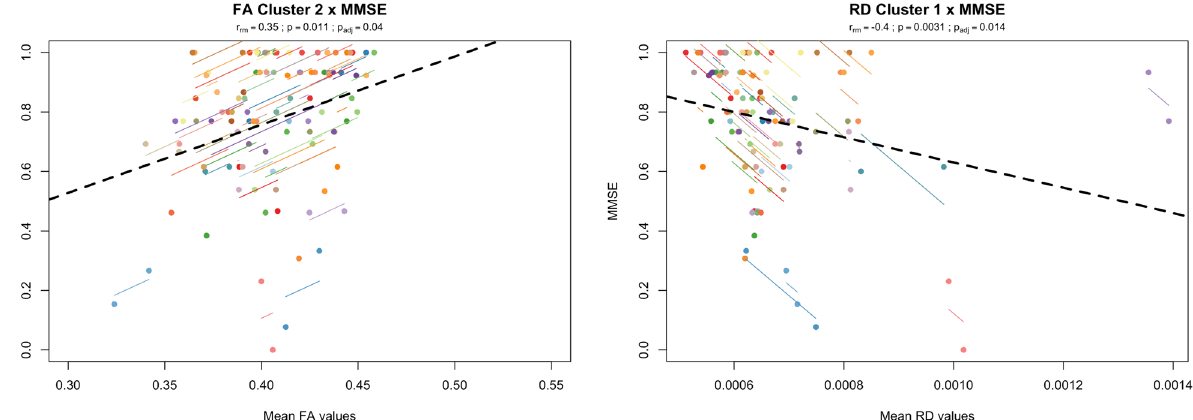
Figure 5. Significant repeated measures correlations between Mini-Mental State Examination (MMSE) and DTI metrics (FA and RD) of clusters with significant changes between timepoints. The x-axis represents average values of each DTI metric and y-axis, the average values of MMSE. Observations from the same individual are represented with the same color, with corresponding lines showing the repeated measures correlation fit for each subject. Dashed black line represents the overall regression line. Only FA cluster 2 and RD cluster 1 were significantly associated with MMSE. FA exhibited a positive correlation, meaning that higher FA values are associated with higher MMSE scores. RD was negatively correlated with MMSE, showing that lower RD values are associated with higher MMSE scores. Overall, these results suggest that higher WM integrity is associated with higher general cognition.